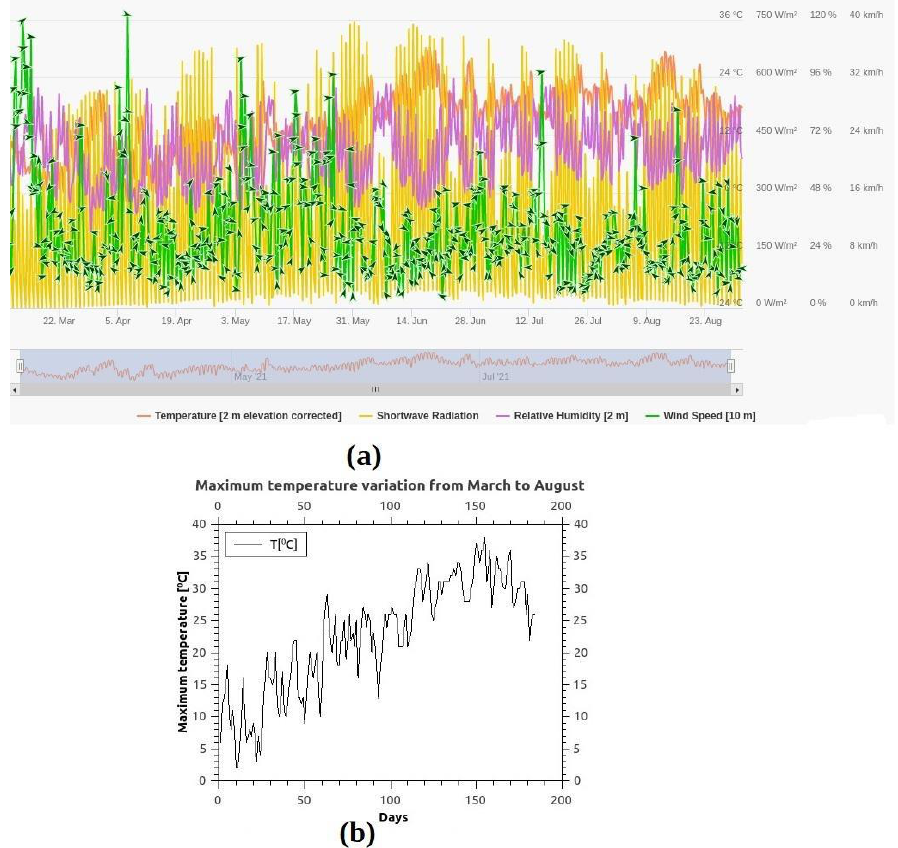
Figure 7. Meteorological parameters variation in Magurele, Romania from March to August 2021: ( a ) Temperature, shortwave radiation, relative humidity, and wind speed (meteoblue.com, accessed on 17 November 2021), ( b ) Variation of the maximum daily temperature in Celsius degree.